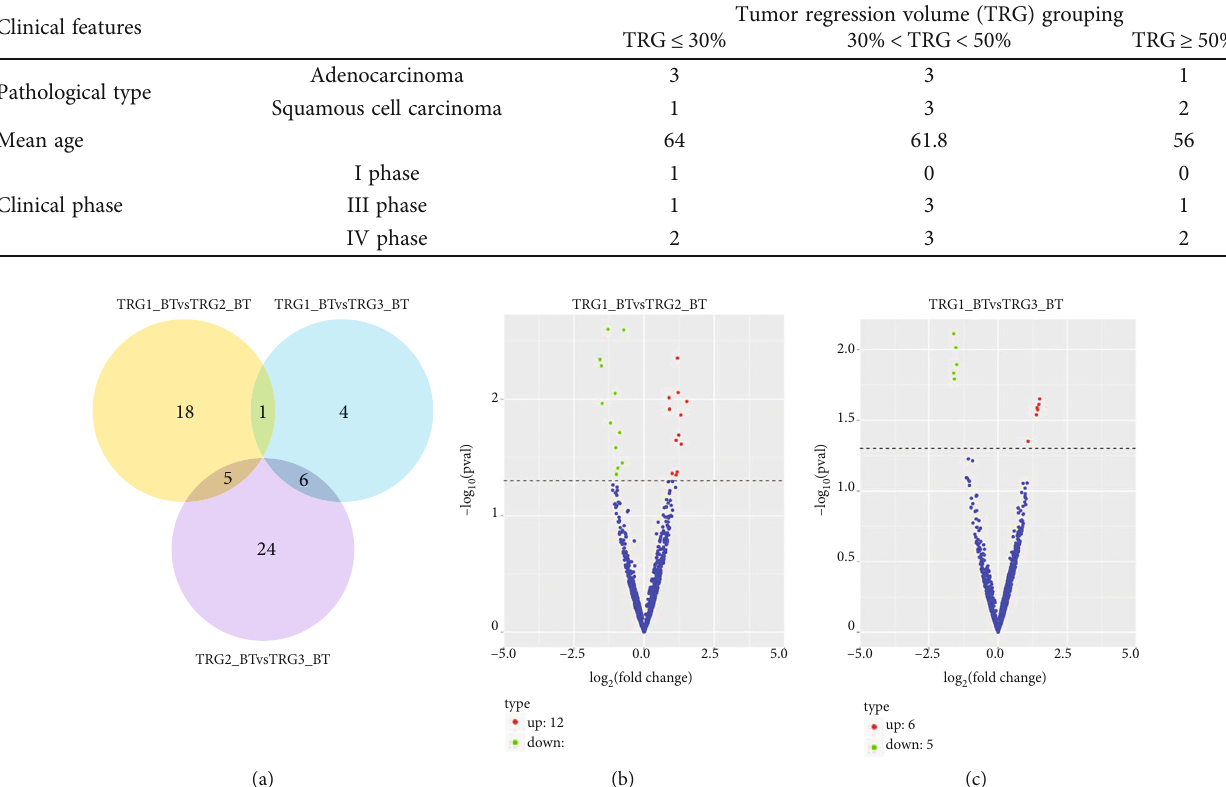
Table 1: Sample grouping.